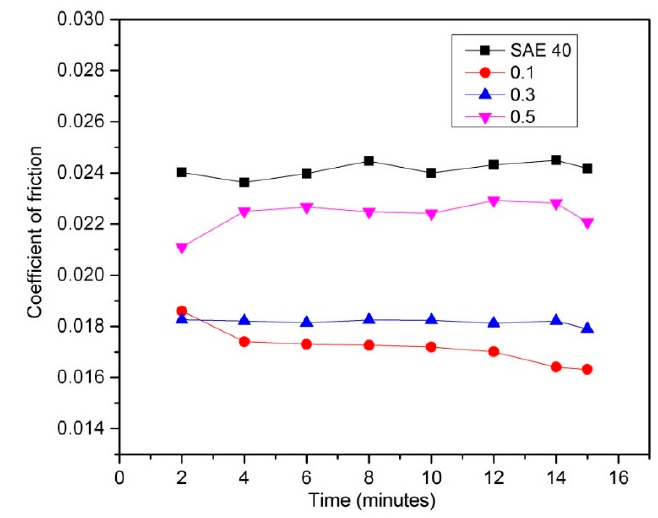
Figure 16. COF results for lubricant sample at high speed low load.